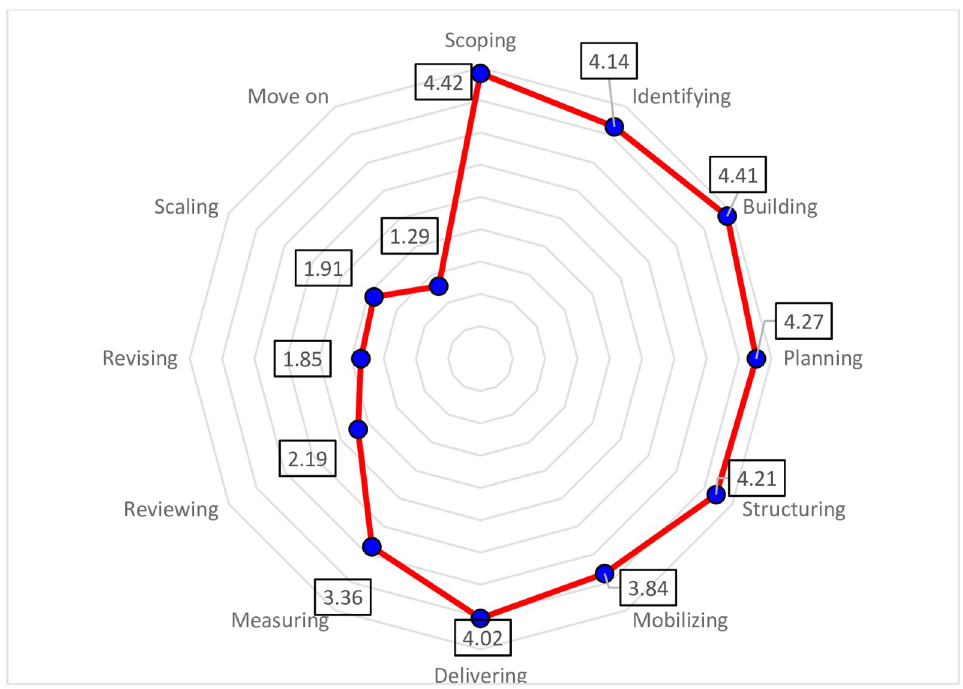
Fig 6. Summary of nonprofit organizations’ implementation of partnering life cycle practices.